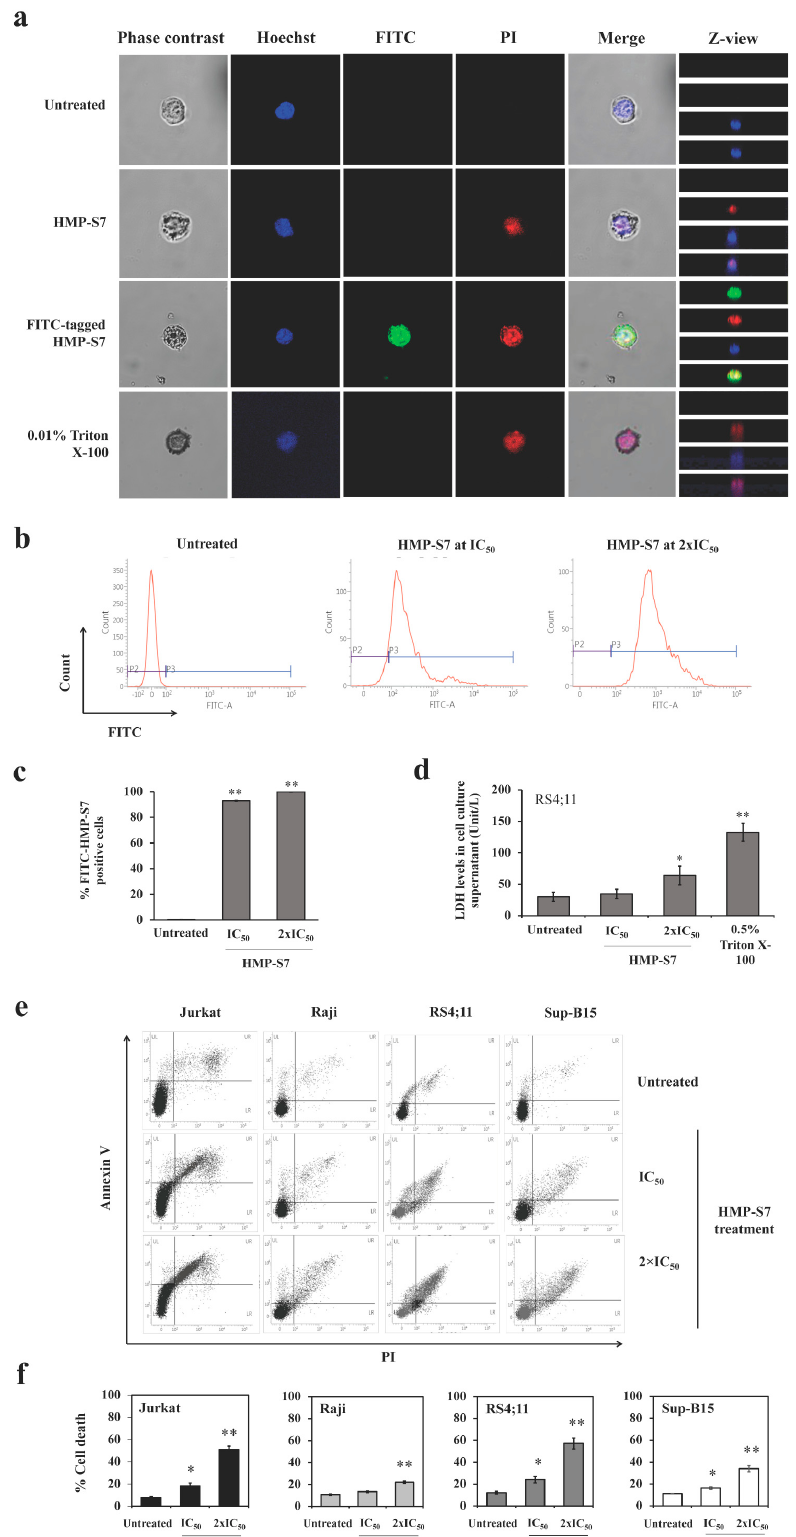
Figure 6. HMP-S7 action on internalization and leukemic cell death. Jurkat cells were treated with HMP-S7 conjugated with or without fluorescein isothiocyanate (FITC) at IC 50 and 0.01% Triton